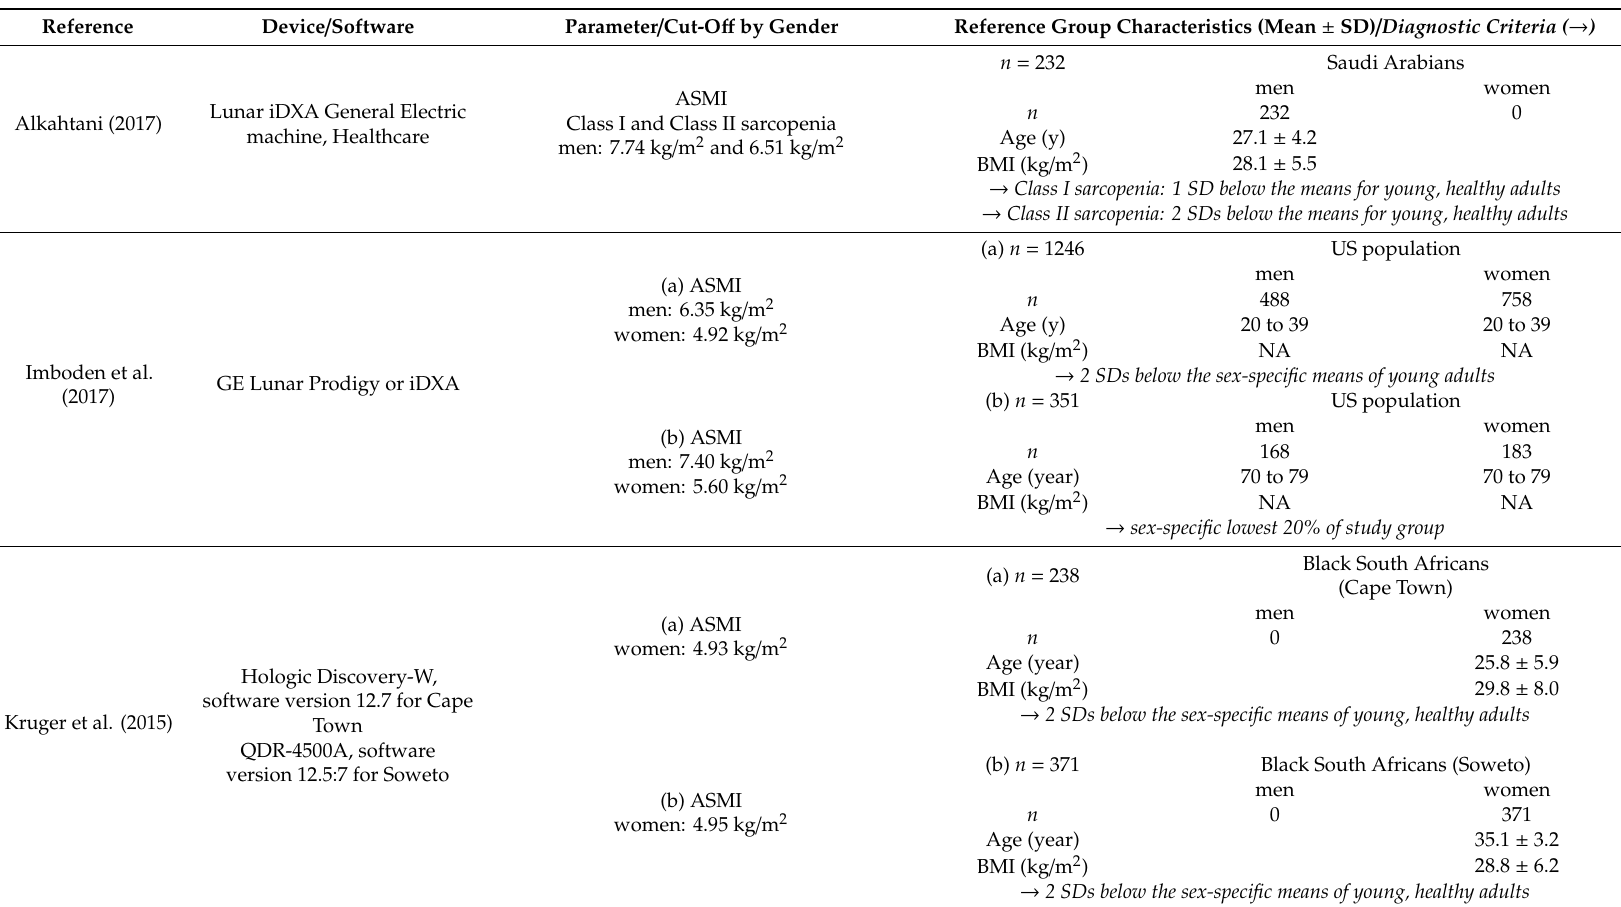
Table 1. Cut-o ff values and diagnostic criteria of a low muscle mass using dual X-ray absorptiometry